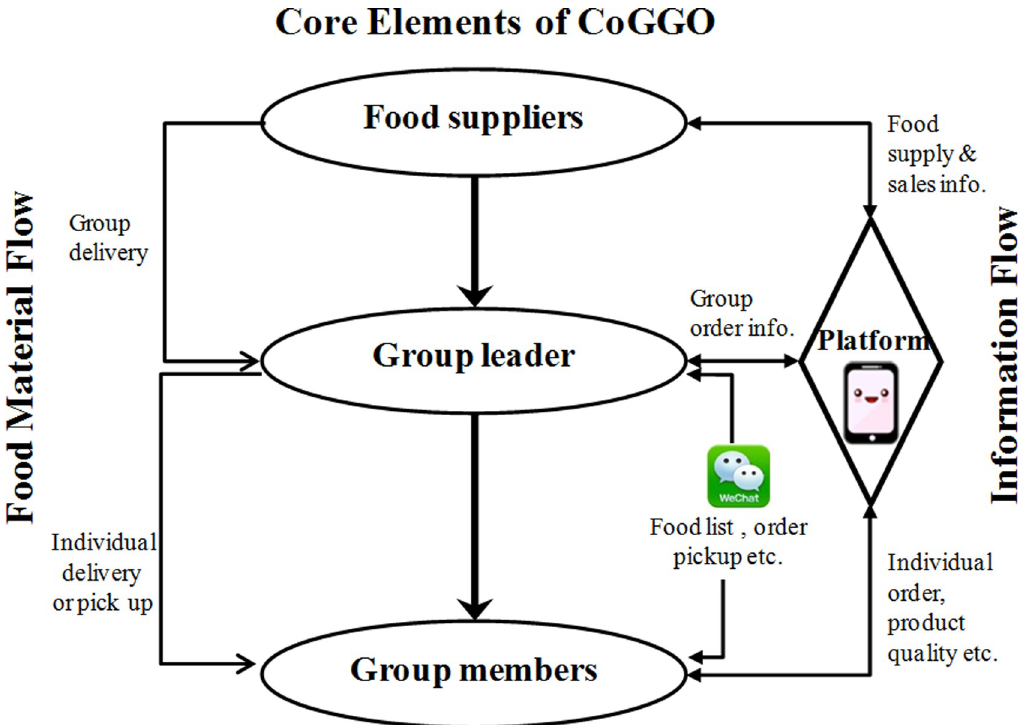
Fig 2. A schematic illustration of CoGGO (community-based online grocery group-ordering) that mushroomed in China during COVID-19 pandemic.